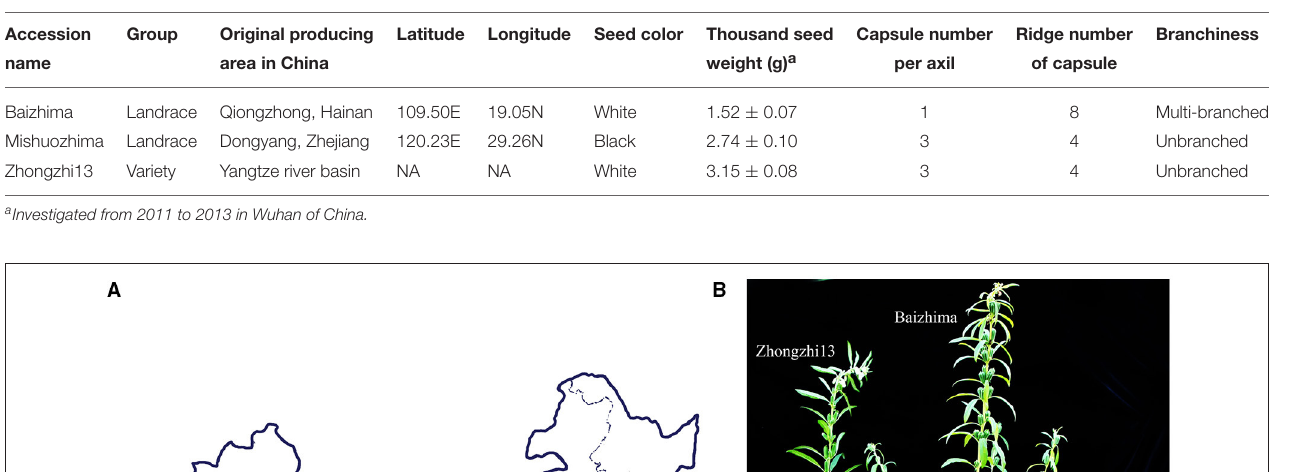
from “Zhongzhi13” genome and annotated by Arabidopsis genes. SNPs and InDels in coding regions were identified by self-customized Perl script from the genome comparison files generated by the diffseq program. Synonymous and non- synonymous SNPs were also districted by self-customized Perl script. And dN/dS rate of each gene was